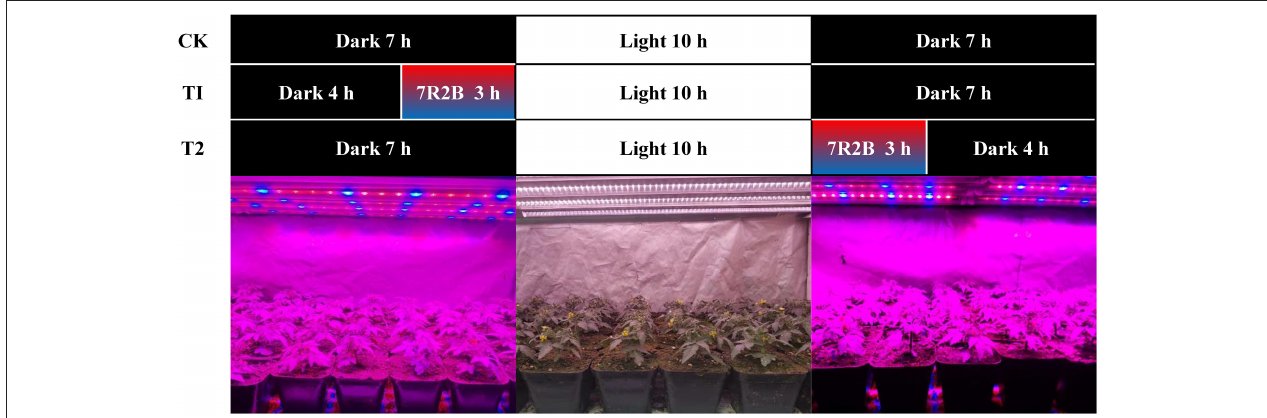
FIGURE 1 | Schematic diagram of the illumination time of each treatment. CK, no light supplementation control; T1, light supplementation for 3h in the morning; T2, light supplementation for 3h in the evening.